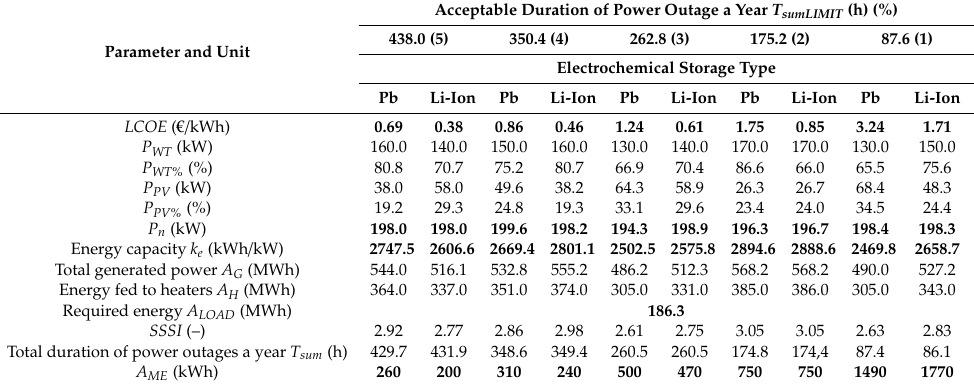
Table 5. Results of PV-wind hybrid power supply system structure optimization (lead–acid and lithium-ion battery) for a 50 kW peak power of a communal load with the power generation system rated power P n limited to 200 kW (for: I ESPb = I ESLi-Ion = 533.3 € / kWh, M ES = 22.2 € / kWh, I ESLi-Ion = 426.7 € / kWh, M ES = 22.2 € / kW, I PV = 1359 € / kW, I TW = 1571 € / kW, M PV = 25.3 € / kW, M WT = 11.1 € / kW, NM = 25 years, r = 5%).